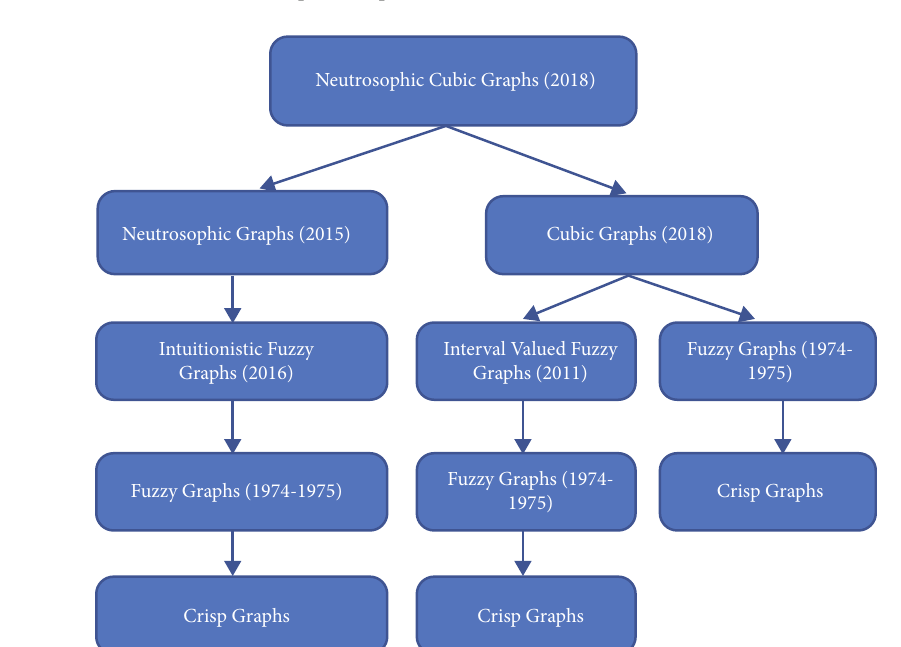
Figure 14: Flow chart of comparison analysis.